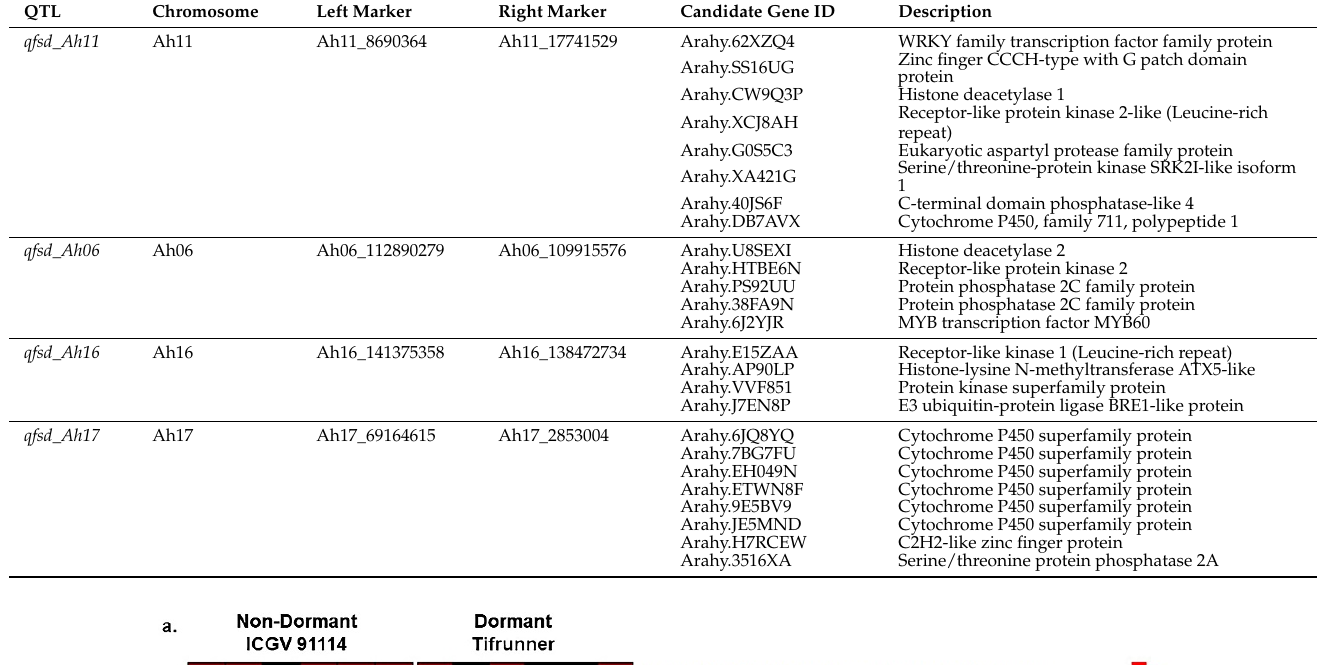
Table 4. Genes associated with FSD identified from major QTL regions showing contrasting expres- sion between dormant Tifrunner and non-dormant ICGV 91114.